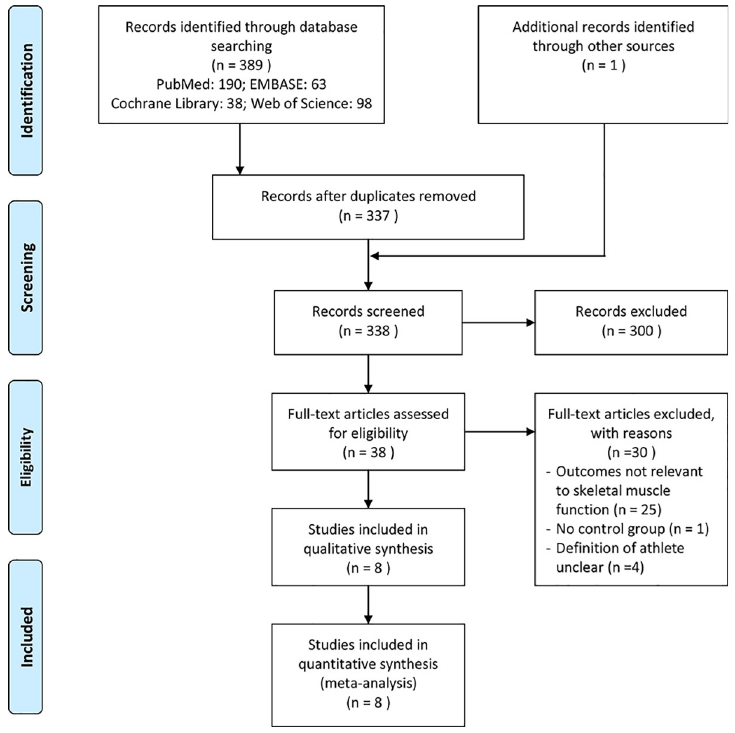
Fig 1. PRISMA 2009 flow diagram for the literature selection